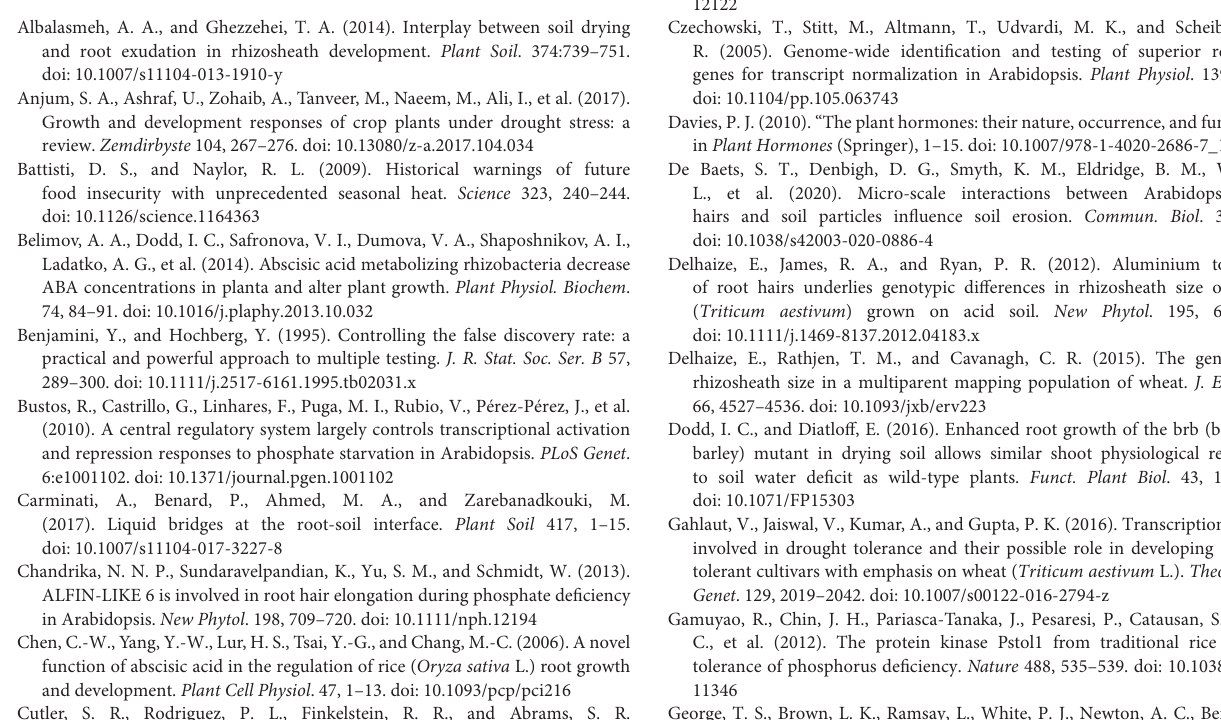
Supplementary Table 1 | Primers used for RT-qPCR expression analysis. Supplementary Table 2 | Summary of read numbers and alignment obtained from RNA sequence of drought-stressed and control